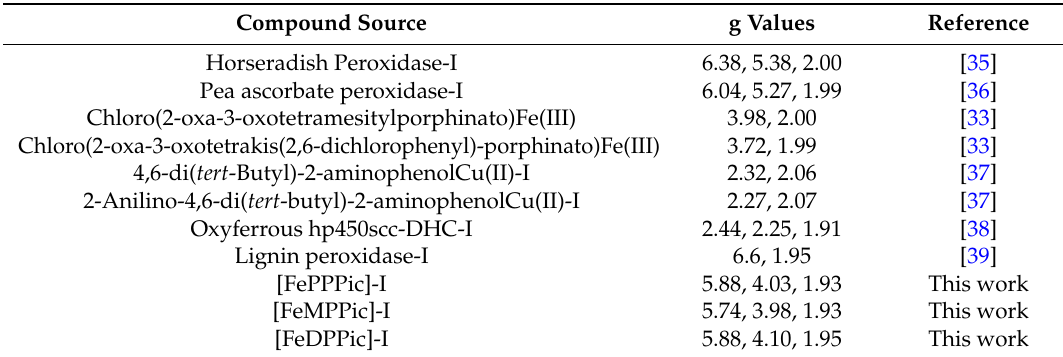
Figure 8. ESR axial spectra of [PPicdienFe IV =O] +· with species of iron ion at higher energy with qms (g > 5.7), proportion decrease from [FePPPic]-I > [FeMPPic]-I > [FeDPPic]-I. Species with s = 3/2 (g ~ 4) and with the highest proportion in each sample. The s = 3/2 corresponds to three unpaired spins, which stem of the Fe(IV) ion low spin ( s = 1) ferromagnetically coupled with radical with s = 1/2, giving a total spin of s = 3/2.